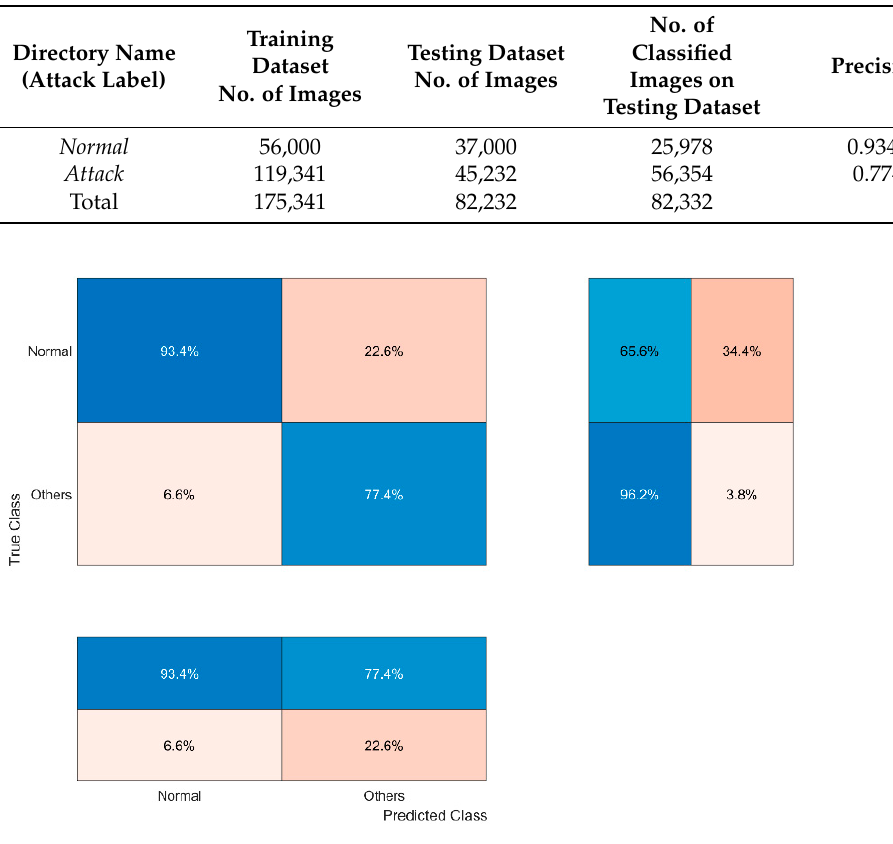
Figure 10. Confusion matrix of the first stage using ML.NET created model on UNSW-NB15 training dataset employing binary classification.